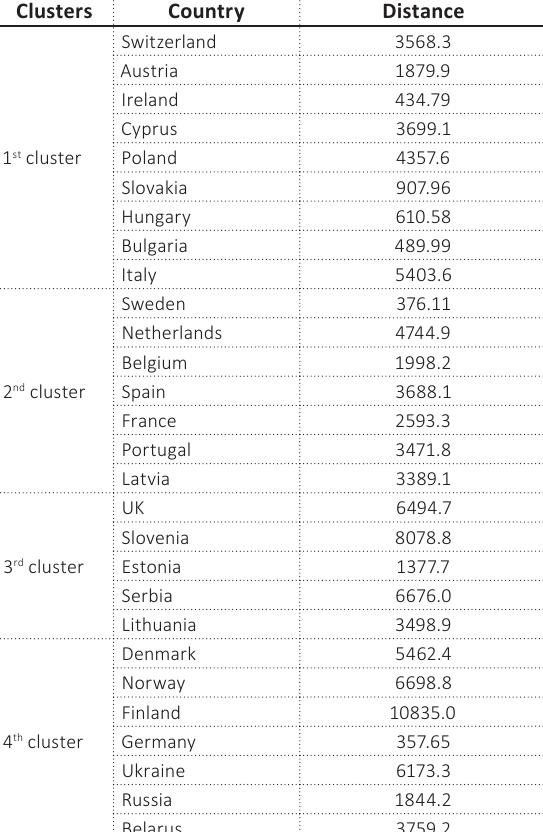
Source: Developed by the